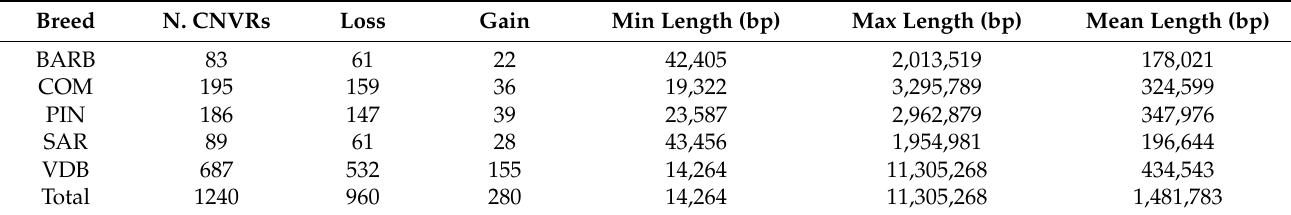
Figure 1. CNV count for 26 autosomes across five breeds. Barbaresca (BARB), Comisana (COM), Pinzirita (PIN), Sarda (SAR), and Valle del Bel ì ce (VDB). The breeds showed similar mean numbers of CNVs, ranging from 20 (SAR) to 27 (COM). BARB showed lowest mean length, while VDB had the longest one. Among identified CNVs, 8052 were deletions (loss) and 2155 were duplications (gain). CNVs ranged from 13,128 bp to 14.99 Mb in size with an average length of 1.81 Mb. no CNV was identified on chromosomes 13, 22, 24, and 26 in the BARB and SAR breeds. Table 2. A total of 1240 CNVRs were obtained across all breeds with 960 losses and 280 gains. Table 2. Summary of CNVRs identified in each